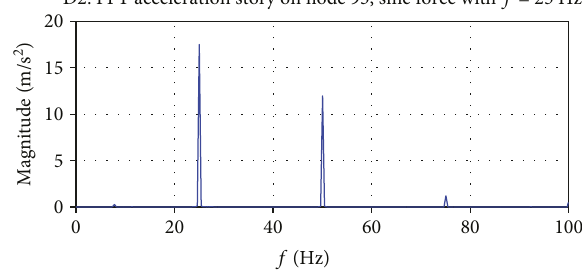
Figure 29: D2, direct response FFT, 25Hz sine excitation.